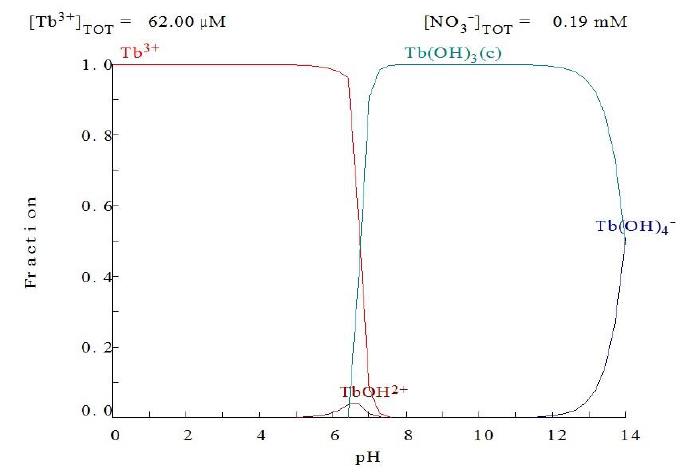
Figure 8. Terbium(III) speciation as a function of the pH values using the Medusa program [31].